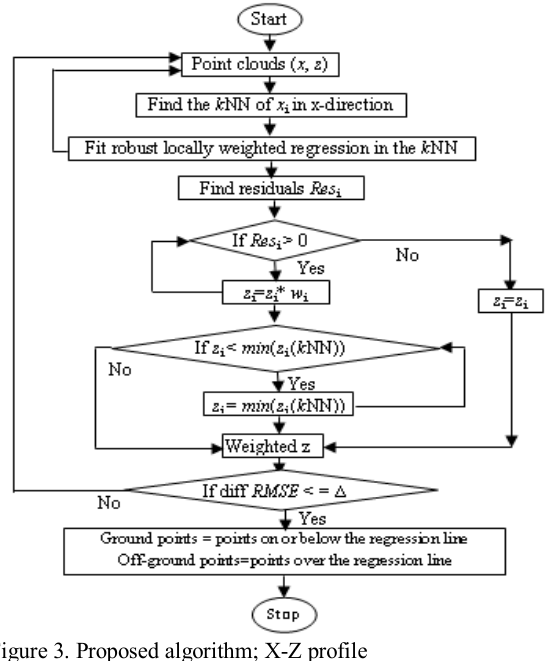
Figure 3. Proposed algorithm; X-Z profile